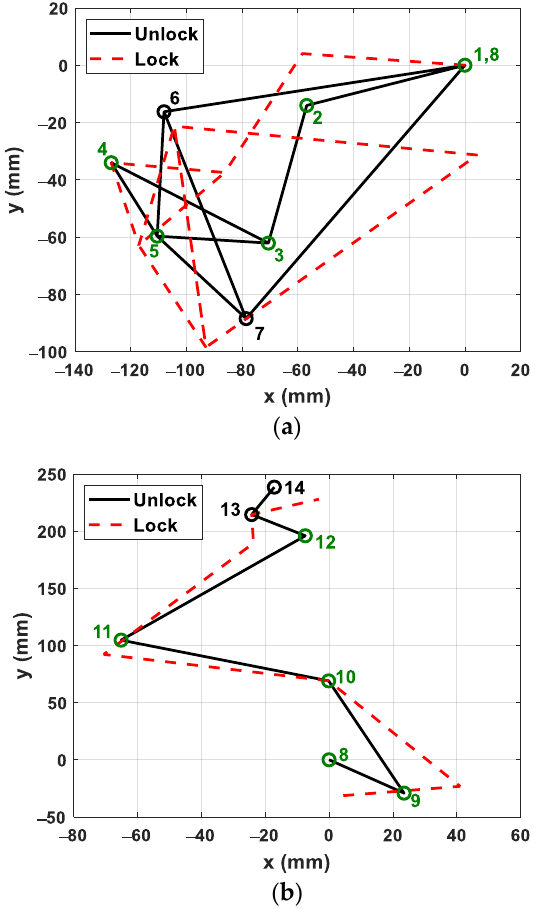
Figure 11. Joint coordinates of Down Lock state and initial unlock state during retraction. ( a ) side-stay link coordinates. ( b ) Link assembly coordinates.